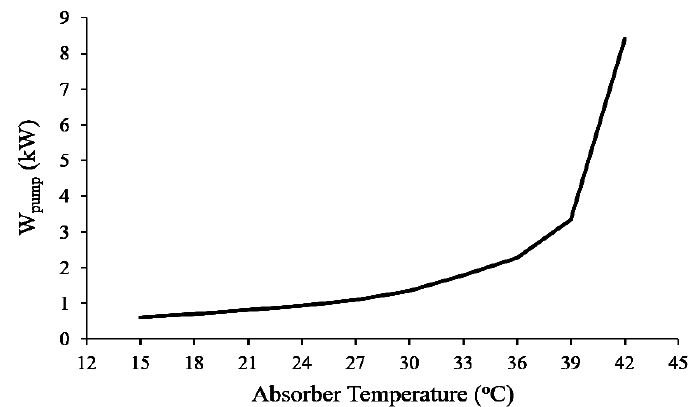
Figure 28. Effect of T abs on pumping power.